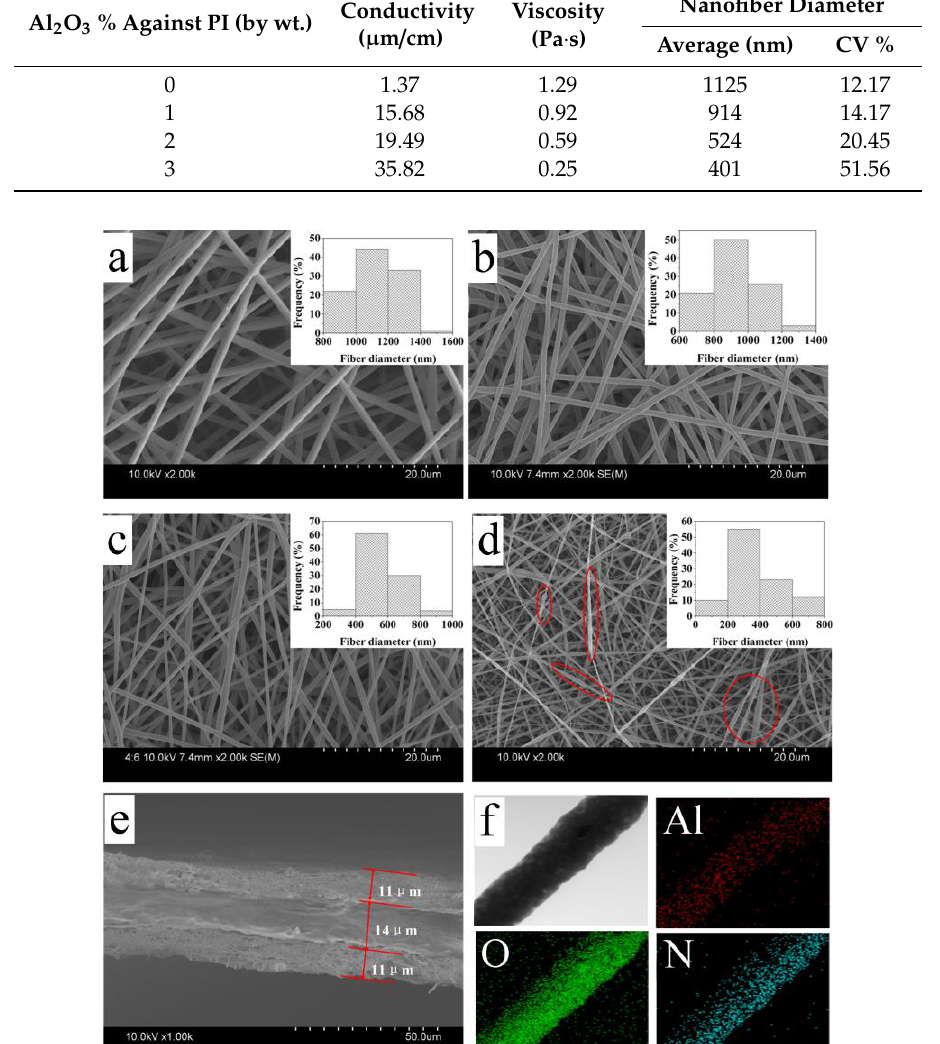
Table 1. Morphology change in PI nanofibers after addition of Al 2 O 3 nanoparticles. Al 2 O 3 % Against PI (by wt.)